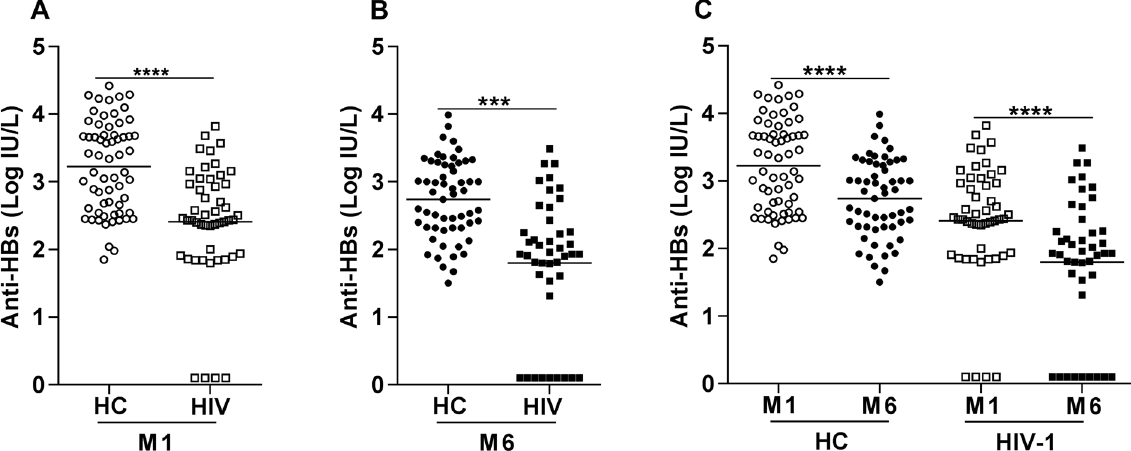
Figure 1. Anti-HBs ab levels in healthy controls and HIV-1 infected children at 1 month and 6 months post- vaccination. Anti-HBs abs were measured in plasma specimens from healthy controls (n = 63) and HIV-1 infected (n = 49) children at baseline and at 1 month ( A ) and 6 months ( B ) [healthy controls (n = 57) and HIV-1 infected children (n = 43) children] after vaccination. All children had undetectable anti-HBV ab levels before vaccination and after three doses of HBV vaccine, all children, except 4 HIV-1 infected (non-responder), responded with production of specific HBV abs. When ab titers to HBV vaccine were compared within the same group of healthy or HIV-1 infected children ( C ), a decline in ab titer was detected at 6 months from the last vaccination dose in both groups. Unpaired T test was used for panels A and B and paired T test for panel C. The lines represent the median values in the figures. *** p < 0.001 and **** p <